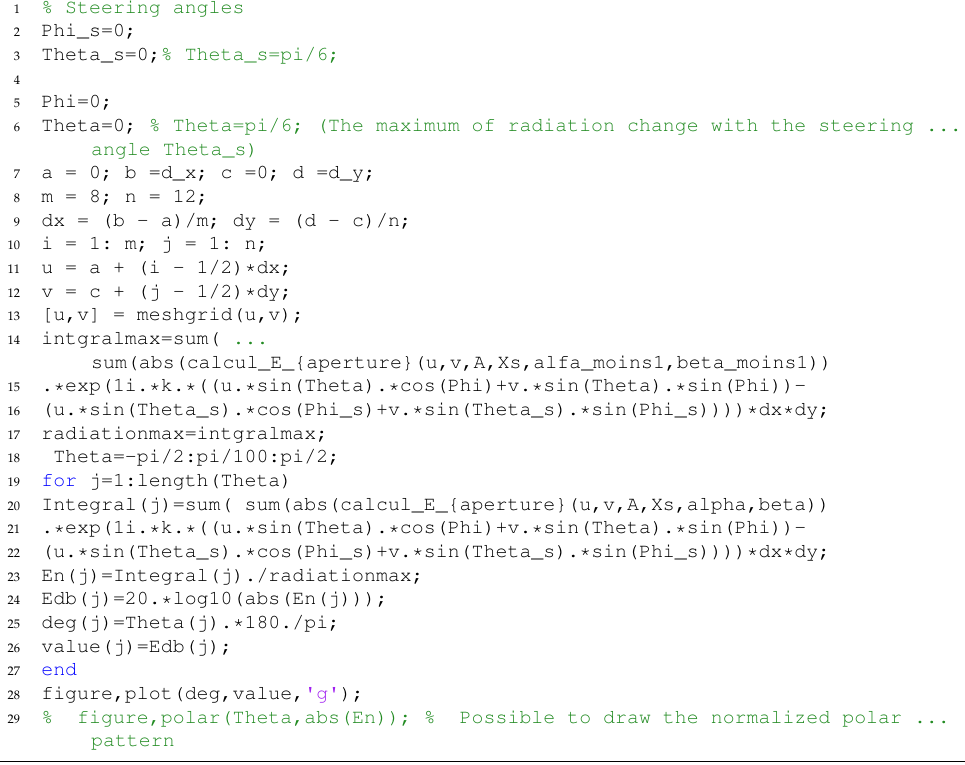
Where Calcul E aperture (u,v,A,Xs,alpha,beta) is the radiating field calculated at the waveguide’s aperture (discontinuity plane) through the moment method combined by